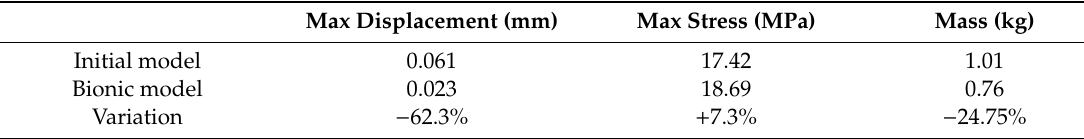
Table 4. Mechanical performances of the new control arm.